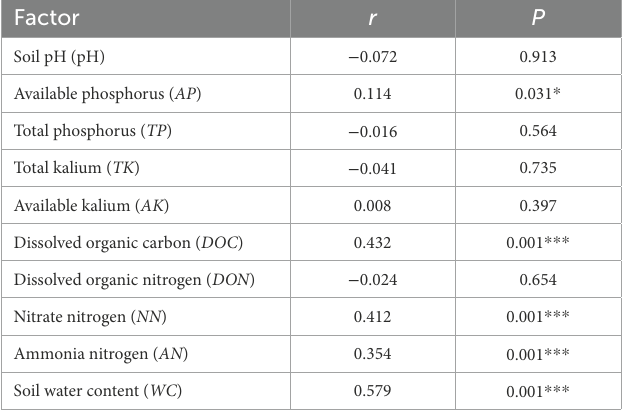
TABLE 4 Mantel test for the correlation between reproductive characteristics and environmental factors of D. angustifolia